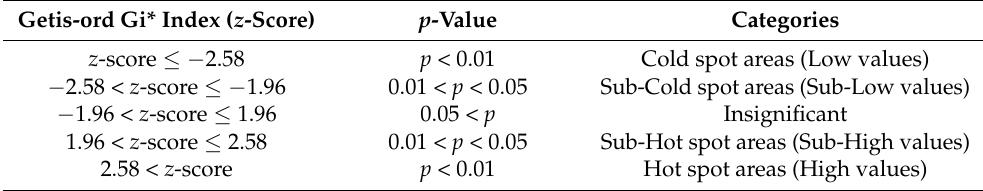
Table 1. Getis-ord Gi* Index categories.